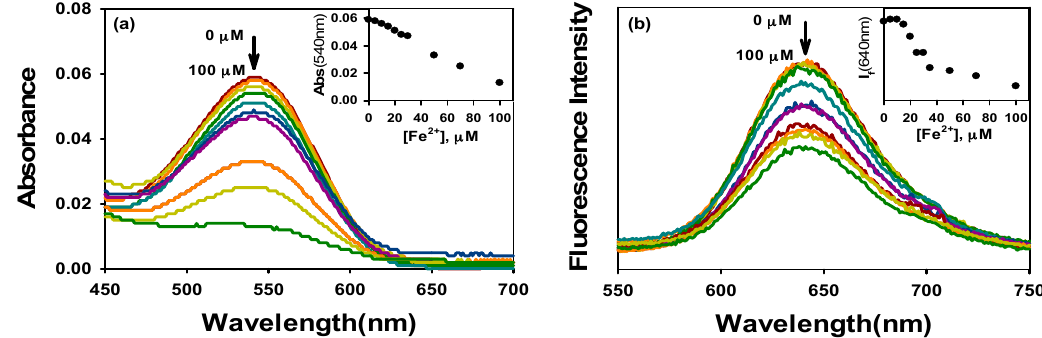
Figure 8. ( a ) Absorption and ( b ) fluorescence spectra of SP-IQ after 350 nm UV irradiation for 7 min with various concentration of Fe 2+ (0~100 µ M, Different color lines represent different Fe 2+ concentrations.). Inset: Plots of ( a ) absorbance at 540 nm and ( b ) fluorescence intensity at 640 nm vs. [Fe 2+ ].